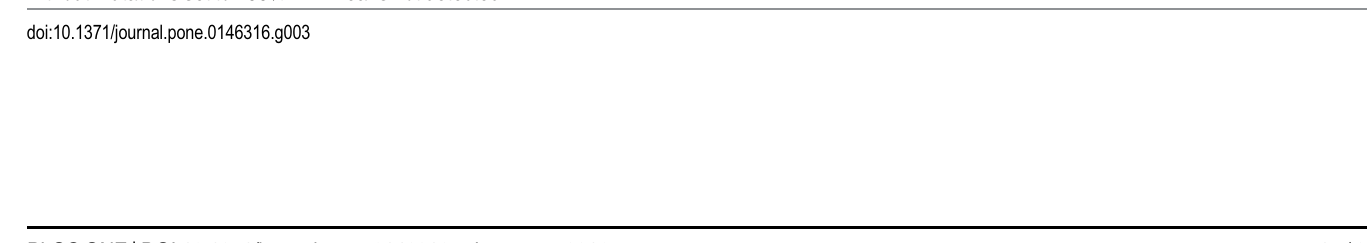
PLOS ONE | DOI:10.1371/journal.pone.0146316 January 5,